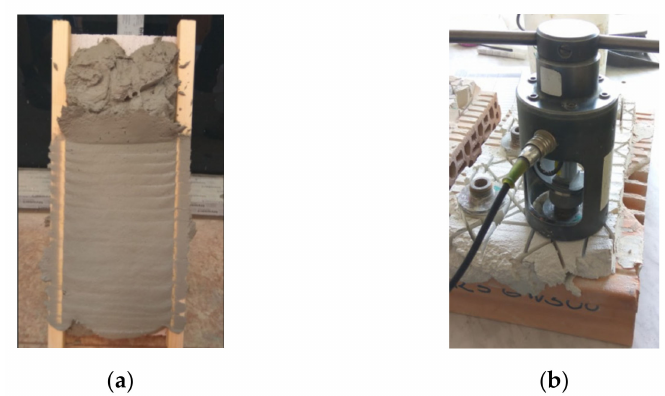
Figure 3. Application of fiber-cement mortar on the substrate of an aerated concrete block ( a ); demonstration of testing the adhesion of fiber-cement mortar to the substrate ( b